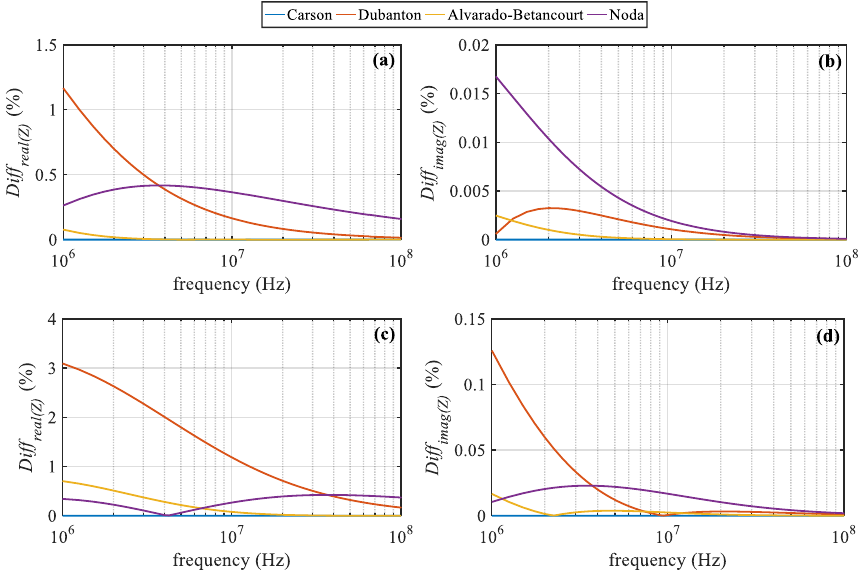
Figure 6. Di ff erences in Z 11 in BB. For ρ g = 100 Ω m, ε rg = 1 and ( a ) real part, ( b ) imaginary part, Figure 6. Differences in Z 11 in BB. F or ρ g = 100 Ωm, ε rg = 1 and ( a ) real part, ( b ) imaginary part, for ρ 1 = for ρ 1 = 1000 Ω m, ε rg = 1 and ( c ) real part, ( d ) imaginary 1000 Ωm, ε rg = 1 and ( c ) real part, ( d ) imaginary part.